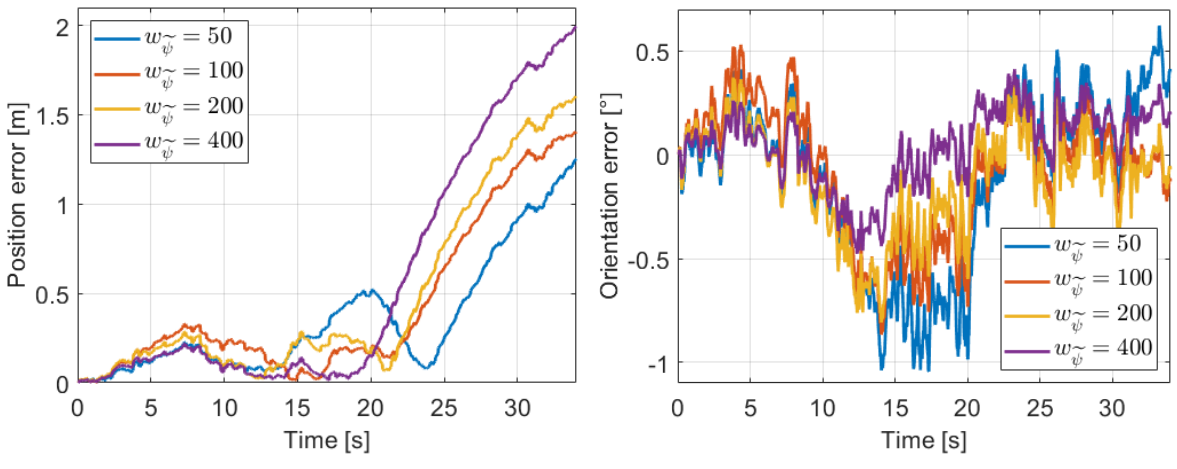
Figure 13. Errors with various w